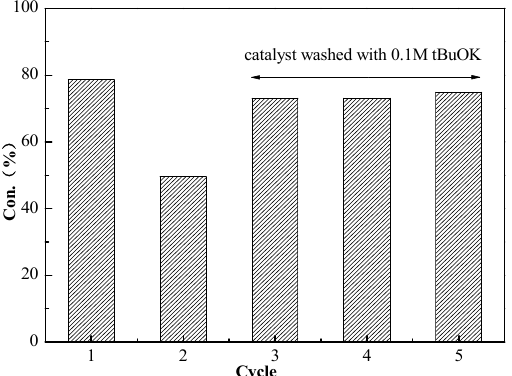
Figure 4. Variation of Knoevenagel condensation between benzaldehyde and malononitrile during five consecutive catalytic uses with BSNC-700-tBu (0.1 M).